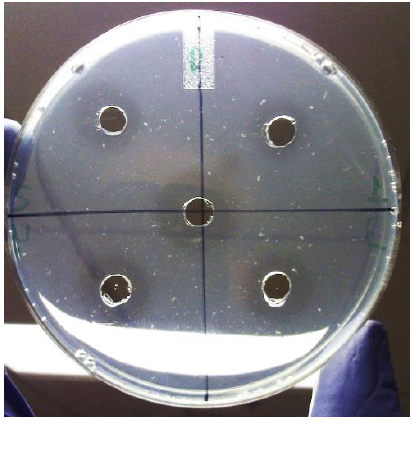
Figure 4. Fibrin plate assay for screening of the plant extract for presence of uPA inhibitory